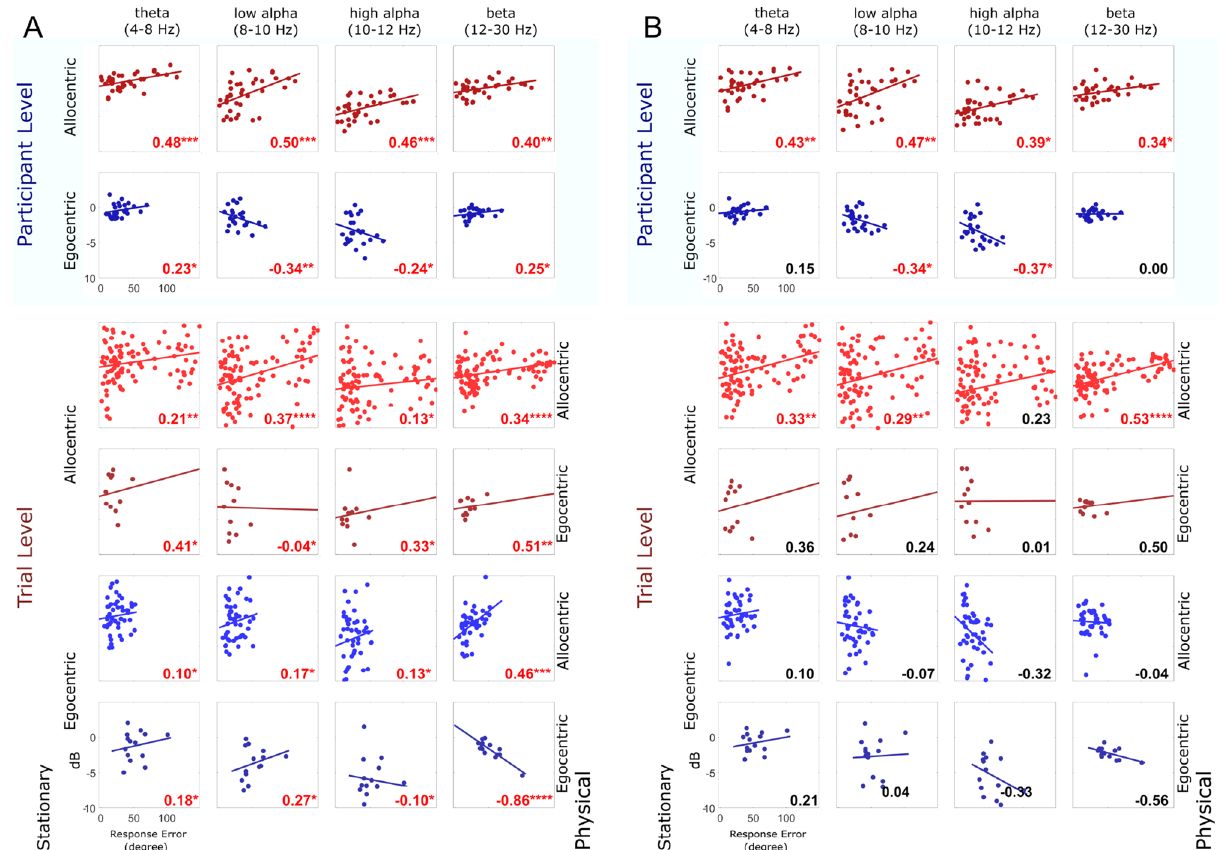
Figure 5. RSC ERSP correlated with participant performance in the first 10 percent ( A ) and mid 10 percent ( B ) of the segment length at both the participant and trial level respectively. The top figure shows the computed correlation coefficients (the number at the bottom right corner, red color indicated for statistical significance; *, **, ***, **** indicated for p <.05, p <.01, p <.001, p <.0001 respectively - FDR-corrected) between individual performance and RSC ERSP at participant level in different frequency band at theta (4-8 Hz), low Alpha (8-10 Hz), high Alpha (10-12 Hz), and beta (12-30 Hz). The row indicates the RFP strategy in the passive RFPT response: red indicates an allocentric, and blue indicates an egocentric strategy. The bottom figure shows the correlation coefficients computed between individual performance and RSC ERSP at the trial level in same the range of frequency as in the top figure. The color-coding indicates the RFP strategy; the lighter color in the same RFP strategy group indicates an active allocentric response, while the darker color indicates an active egocentric trial